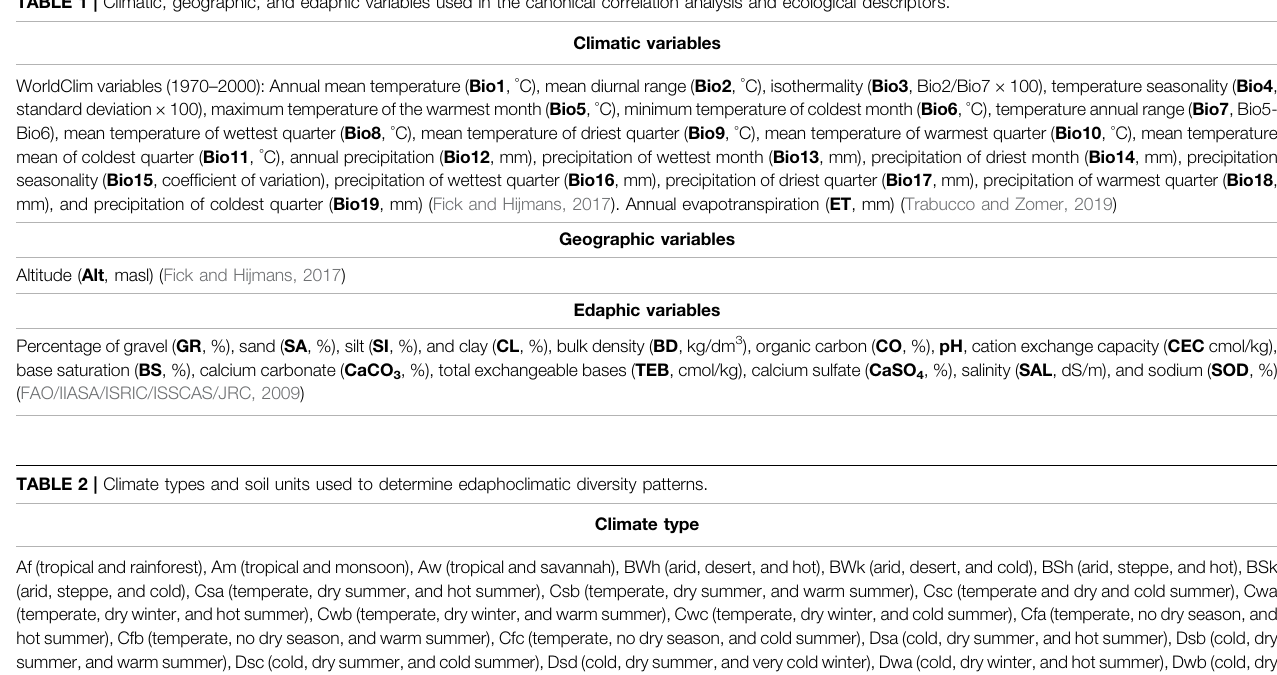
TABLE 1 | Climatic, geographic, and edaphic variables used in the canonical correlation analysis and ecological descriptors.